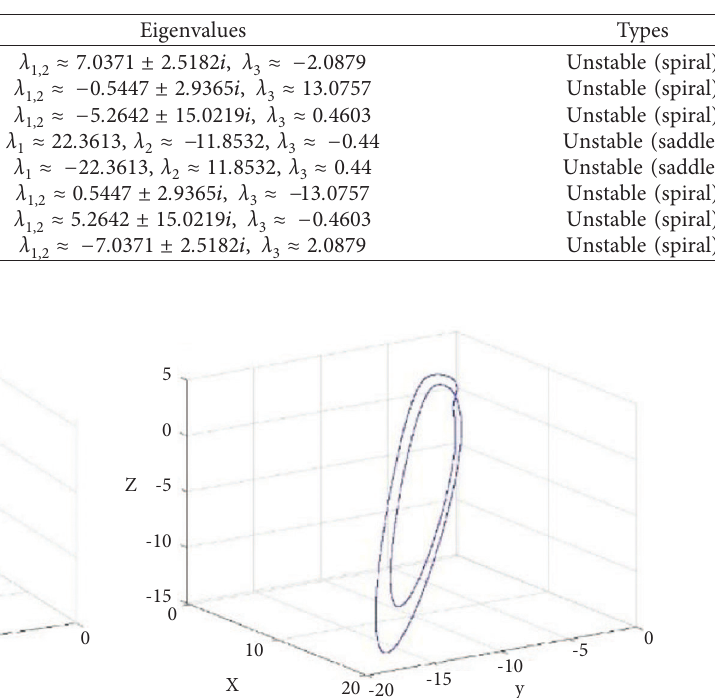
Table 1: The pure nonlinear system’s equilibrium points and their related eigenvalues when a � 0 . 5 and b � − 2 . 3 are set. The equilibria types are determined based on their eigenvalues.